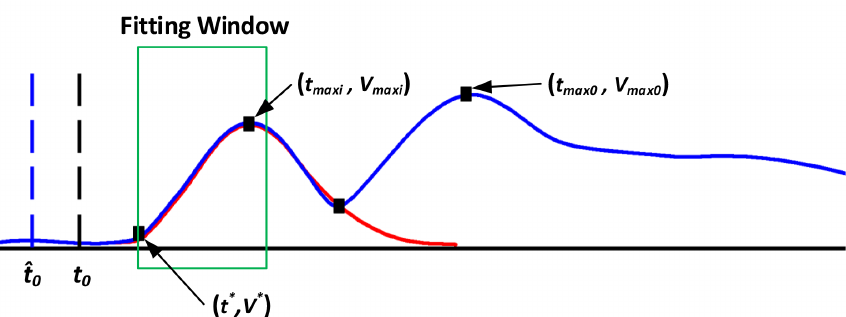
Figure 6. Curve-fitting result of envelope waveform in the desired region. (Blue line: echo envelope; red line: curve-fitting